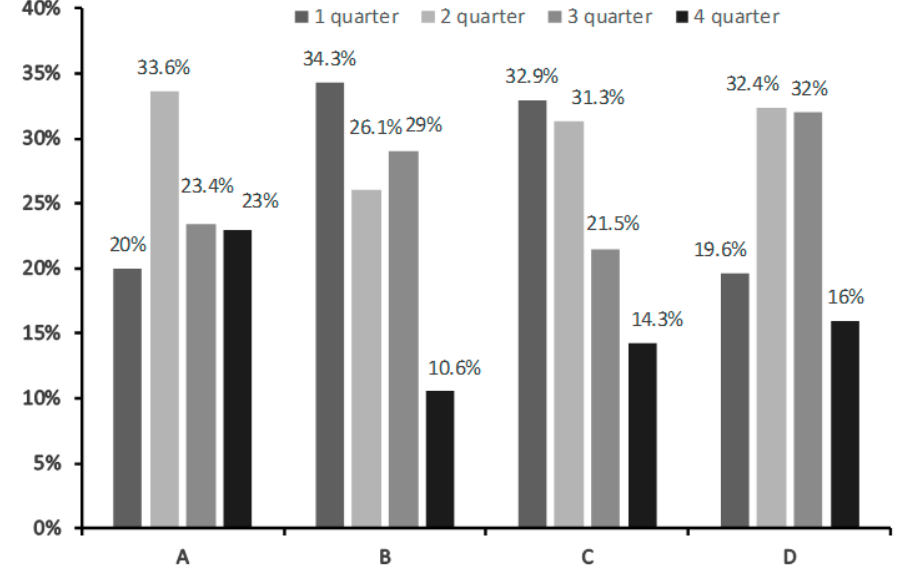
Figure 3. The prevalence of Relative Age Effect in middle tier soccer academies: Kozhany Myach Roman Pavlyuchenko Children’s ( A ), subdivision of Football School Lokomotiv ( B ), subdivision of Football Academy Chertanovo ( C ), and Children’s and Youth Sports School of Stavropol ( D ).